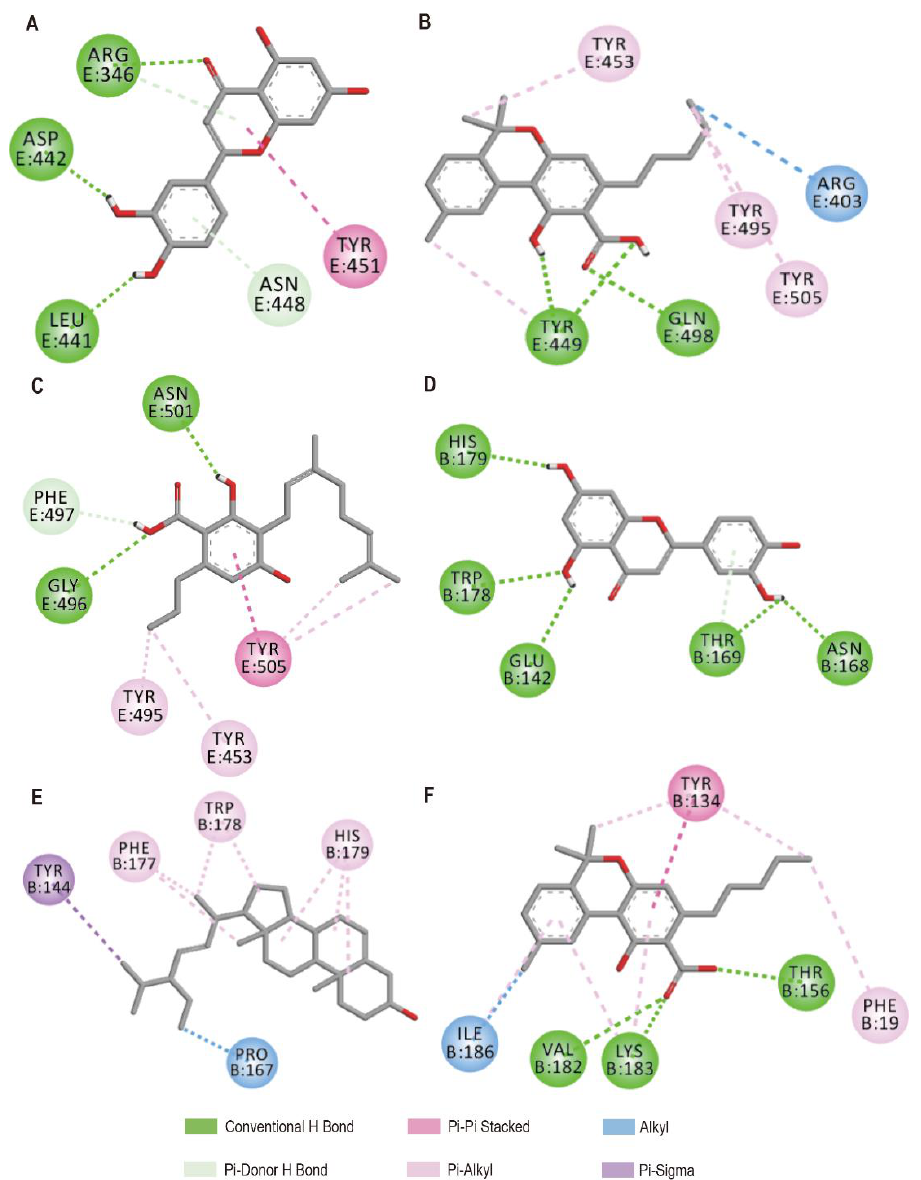
Figure 1. 2D interactions of a complex of RBD-ACE2 of SARS-CoV or SARS-CoV-2 with top three bioactive molecules luteolin ( A ), CBNA ( B ), CBGVA ( C ), luteolin ( D ), stigmasterol ( E ), CBNA ( F ).